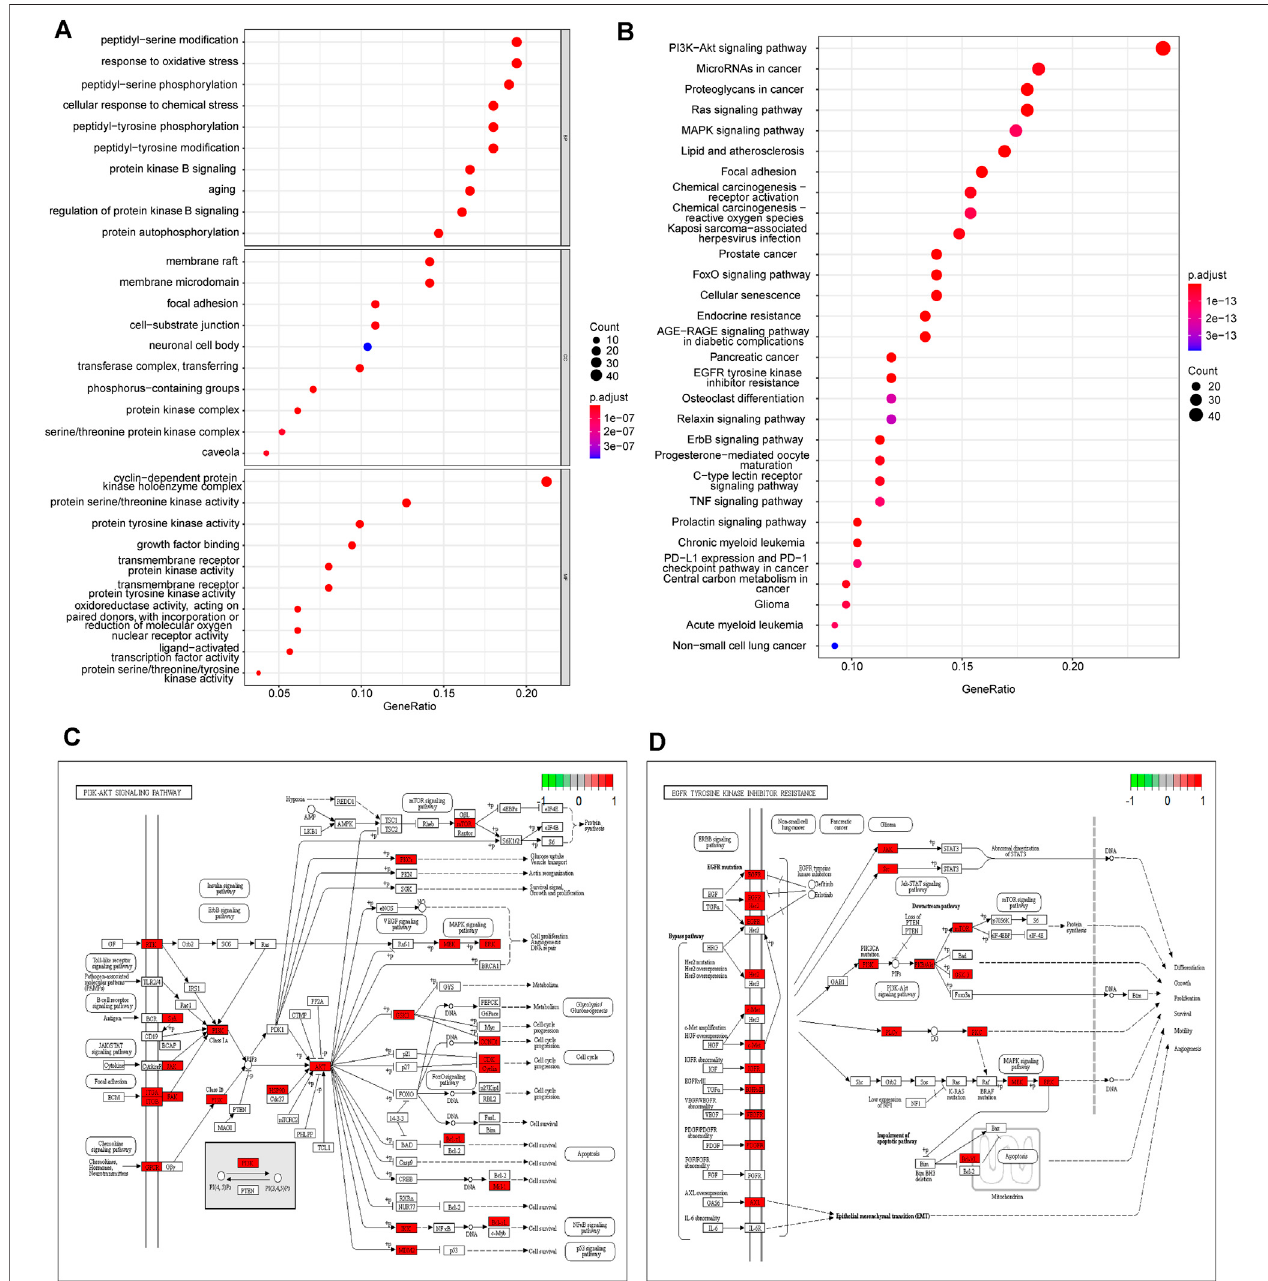
FIGURE4| GOandKEGGenrichmentanalysis. (A) Thetop10enrichedGOitemsofBP,CC,andMF. (B) Thetop30enrichedKEGGpathways. (C) Theimportant target genes were mainly distributed in the PI3K-AKT pathway. (D) The important target genes were mainly distributed in the EGFR tyrosine kinase inhibitor resistance